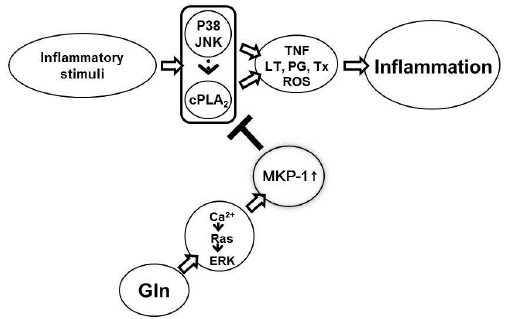
Figure 5. Anti-inflammatory action mechanisms of Gln. Gln binds to G-protein coupled receptors (GPCRs), an allosteric receptor, (unpublished data), and increases ERK activity via activation of the pathway involving Ca 2+ /Ras/c-Raf/MEK (ERK cascade) [41]. ERK phosphorylates MKP-1 on two carboxyl-terminal serine residues—serine 359 and serine 364, which enhances MKP-1 stabilization, resulting in the early induction of MKP-1 [20]. MKP-1 deactivates cPLA 2 either by dephosphorylating p38 [20,23], which is a major upstream pathway for cPLA 2 phosphorylation, or by directly dephosphorylating cPLA 2 due to enhanced physical interaction between Gln-induced MKP-1 and cPLA 2 [24]. Deactivation of p38 and cPLA 2 results in suppression of many cardinal inflammatory mediators including reactive oxygen species.